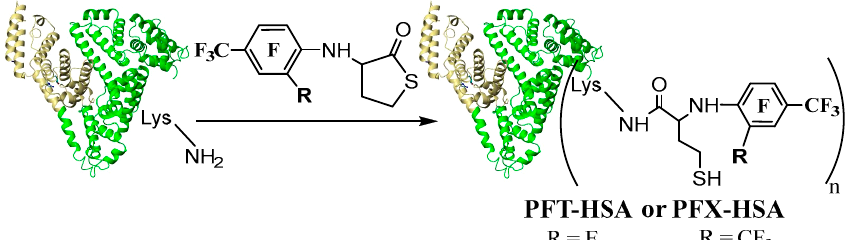
Figure 7. Synthetic route to PFT-HSA ( n = 3.9 ± 0.1) and PFX-HSA ( n = 4.9 ± 0.1) conjugates. Frame- work (shown schematically as a heart-like structure)—human serum albumin (HSA).